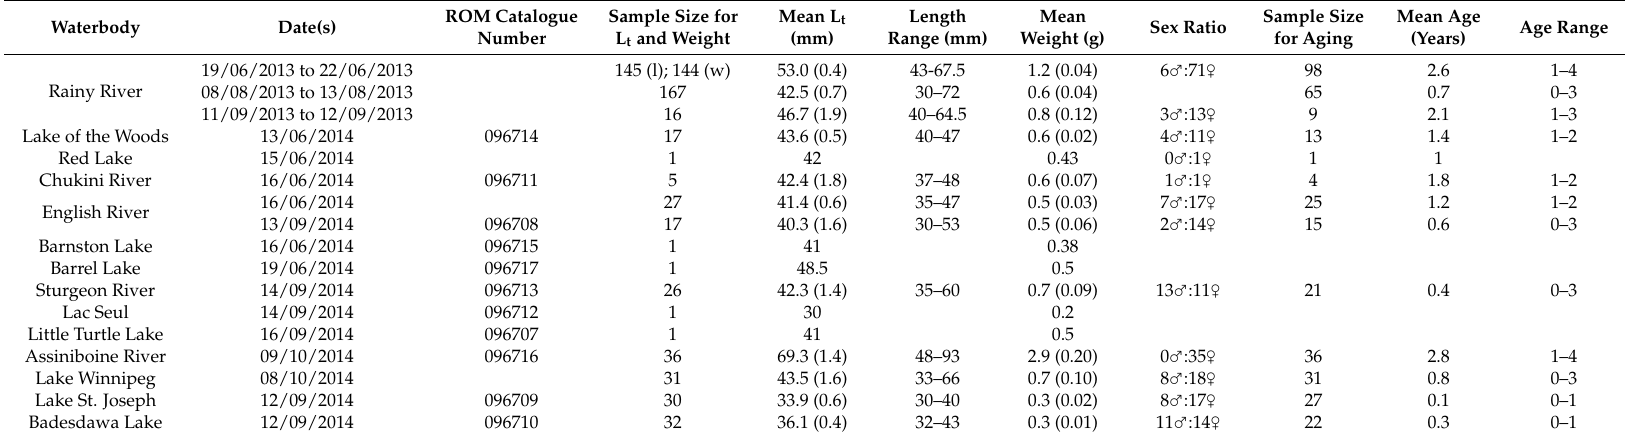
Table 4. Mean total length (l t ) length range (mm), mean weight (g), and sex ratio for River Darters captured and assessed from DFO-led surveys. Numbers in brackets represent ± standard error. The Royal Ontario Museum (ROM) catalogue number is provided when available.